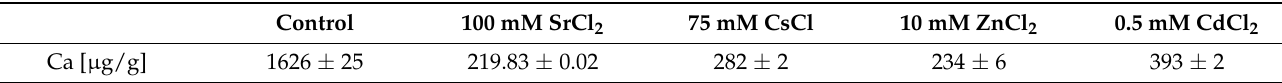
Table 1. Calcium concentrations in S. commune 12-43 grown under metal stress.